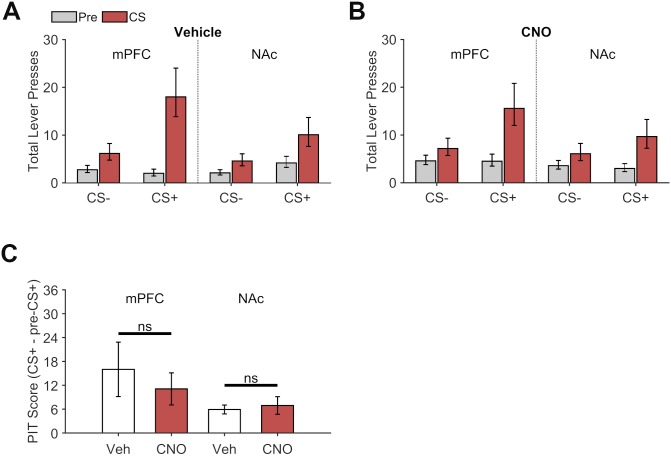
Frequency of lever presses during PIT testing by rats expressing mCherry following microinjection of vehicle (A) or CNO (B) into the mPFC or NAc in Experiment 3B.Data from pre-CS (gray) and CS (red) periods are plotted separately. Error bars represent ±1 standard error of the estimated marginal means from the corresponding fitted generalized linear mixed-effects model. The CS+ induced a cue-specific increase in lever pressing (CS Type * CS Period interaction, t(176) = 4.51, p<0.001). Rats in the NAc group exhibited a marginally weaker CS+ specific increase in lever pressing than rats in the mPFC group (Site * CS Type * CS Period interaction, t(176) = −1.89, p=0.060). CNO appeared to slightly attenuate CS+ elicited lever pressing, particularly when injected into the mPFC, though this effect was not significant (effect was not significant (Drug * CS Period * CS Type interaction, t(176) = −0.0022, p=0.998; Site * Drug * CS Period * CS Type interaction, t(176) = 1.83, p=0.068). (C) A focused analysis of CS+ elicited lever pressing (PIT Score; ±1 between-subjects SEM) confirmed that CNO injections did not significantly disrupt this effect in either the mPFC (t(5) = 1.63, p=0.165) or NAc (t(5) = 0.33, p=0.753) group. These results indicate that the tendency for intra-NAc CNO injections to disrupt CS+ elicited lever pressing in hM4Di expressing rats in Experiment 3A (see Figure 4, main text) was due to dopamine terminal inhibition and not a nonspecific CNO effect.